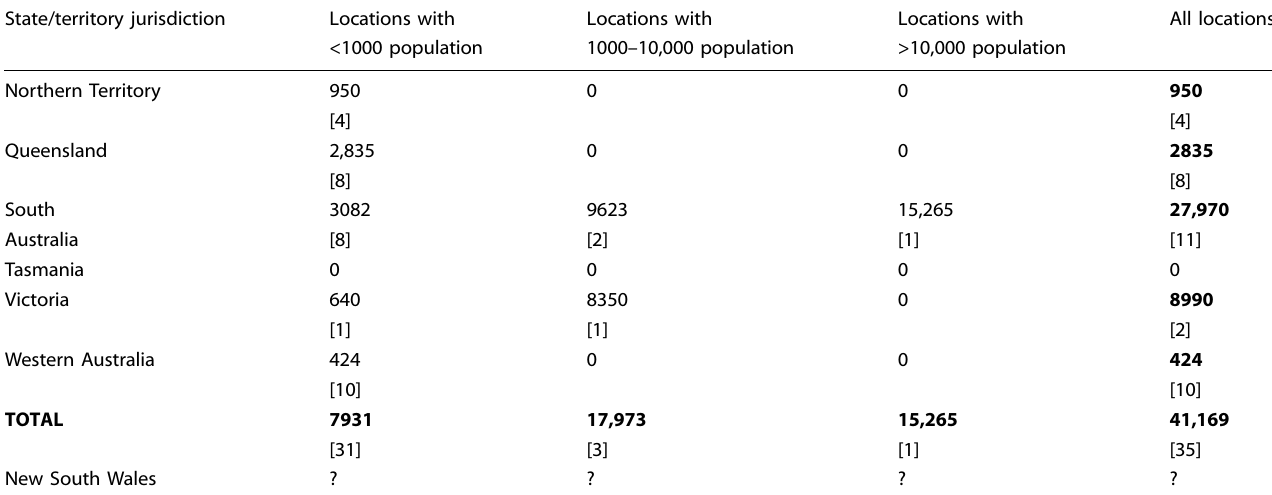
Table 2. Population and number of locations in regional and remote Australia reported to lack access to the ‘ SDG 6.1 ’ de fi nition of a basic level of drinking water quality.